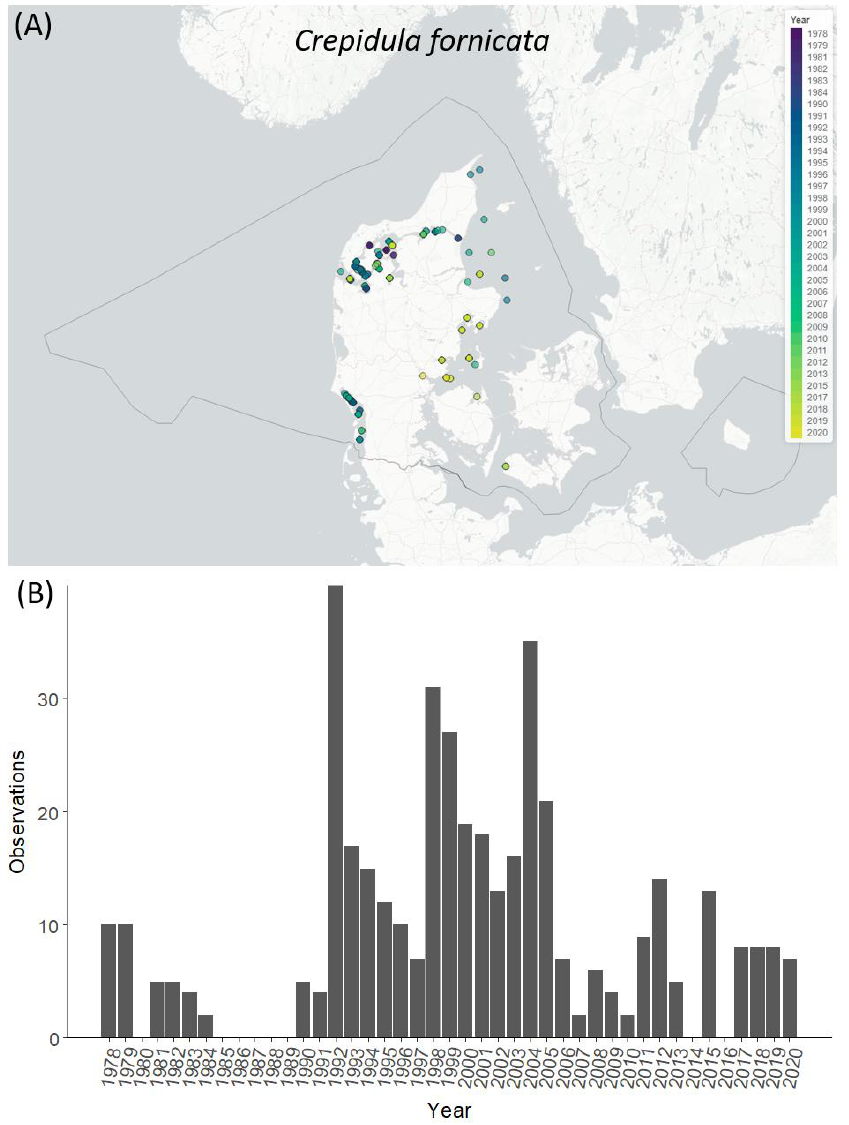
Figure 13. Map showing distribution of Crepidula fornicata from the NOVANA database from the beginning of the monitoring project ( A ); occurrence in different years from all NOVANA stations ( B ).